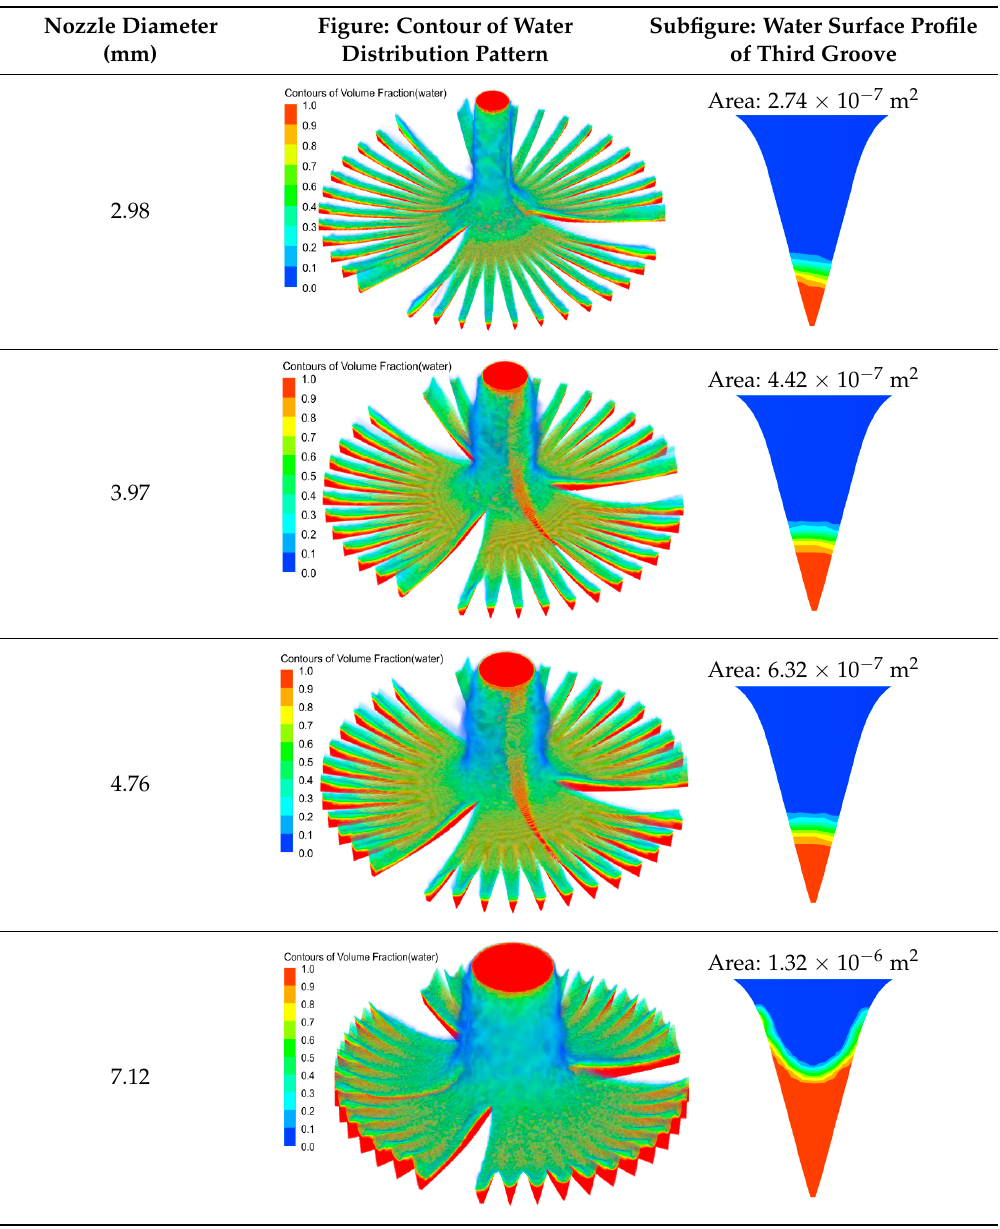
Table 3. Contours of the water fraction at 200 kPa of working pressure. Figure: Contour of Water